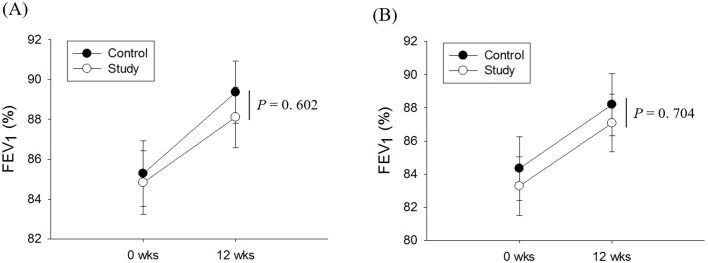
FEV1 improvement after 12 weeks in FAS (A) and PPS analysis (B).The t-test or Wilcoxon’s signed rank test were used to analyze improvement within groups, and ANCOVA was used for comparisons of improvement between the two groups. The data are presented as the mean (dot) and standard error of the mean (bar). FEV1, forced expiratory volume in the 1st second; FAS, full analysis set; PPS, per-protocol set.